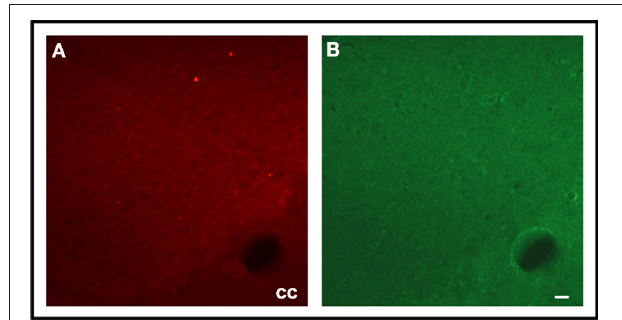
FIGURE 5 | Photographs of epifluorescence microscopy showing CS sections from a representative EF2 animal subjected to TH immunostaining (A) followed by Fluoro-Jade C staining (B). Note the absence of FJC-positive cells surrounded by TH-positive neuronal terminals. cc = corpus calosum, Scale bar = 40 μ